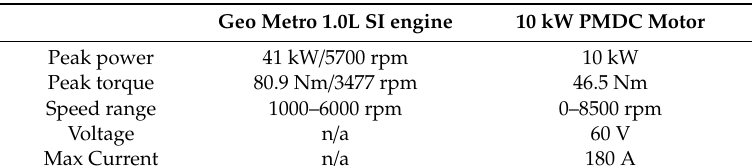
Table 1. Engine specification.